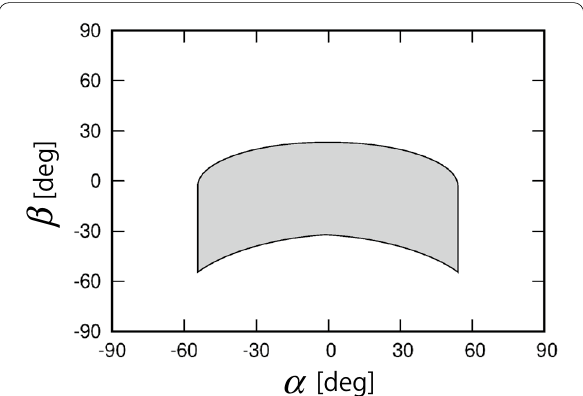
Table 1 Properties of items of the entire system